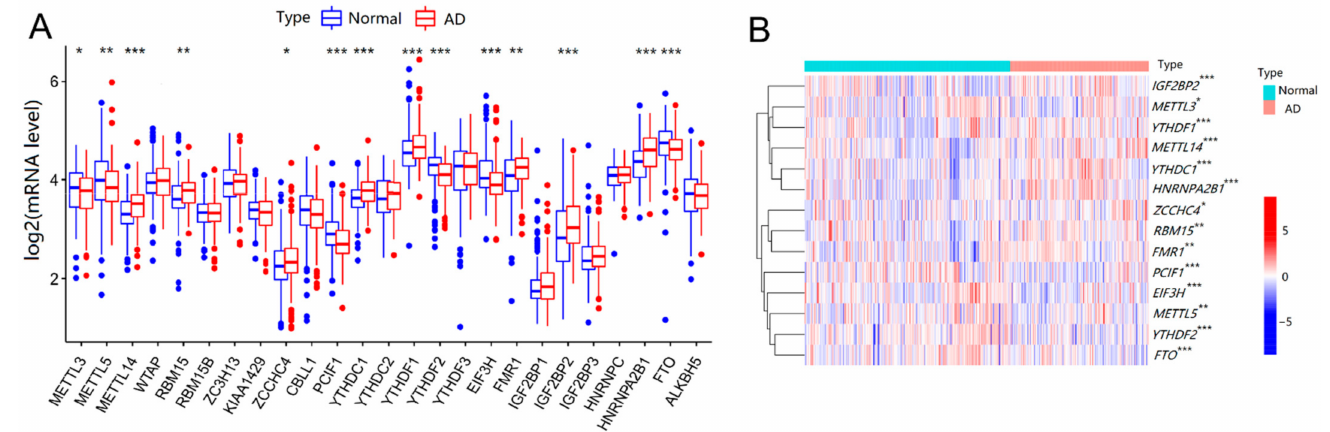
Figure 1. Expressions of m6A methylation regulators between normal controls and AD patients. ( A ) Differential expression boxplot of the 25 identified m6A regulators. ( B ) Expression heat map of 14 differential m6A regulators. The t -test was used to analyze the difference in the expression levels of m6A regulators. Compared with the controls, * p < 0.05, ** p < 0.01, and *** p <